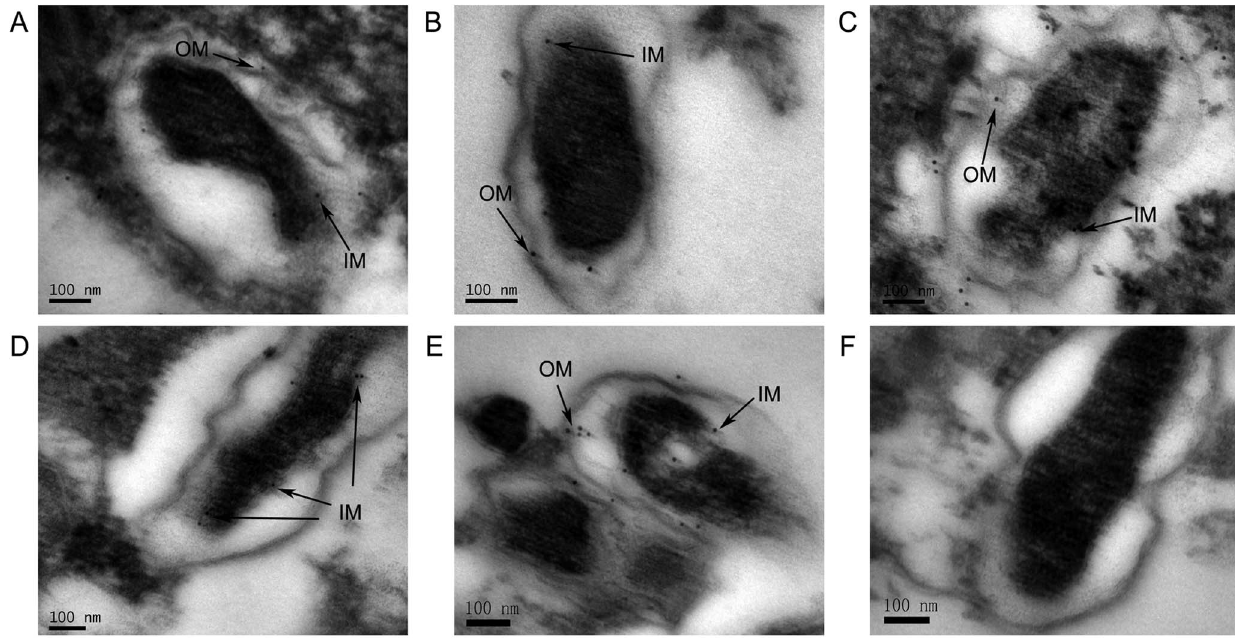
Figure 6. Detection of surface-exposed proteins using immuno-electron microscopic assay. Vero cells infected with R. rickettsii were incubated with anti-rAdr1 (A), -rAdr2 (B), -rOmpW (C), -rPorin_4 (D), -rTolC (E), or -PBS (F) serum and subsequently immunolabeled with colloidal gold particles (10 nm) using standard procedures. The cells were then observed by transmission electron microscope. The black arrows indicate target SEPs in the inner membrane (IM) and outer membrane (OM) of R. rickettsii . Bar =100